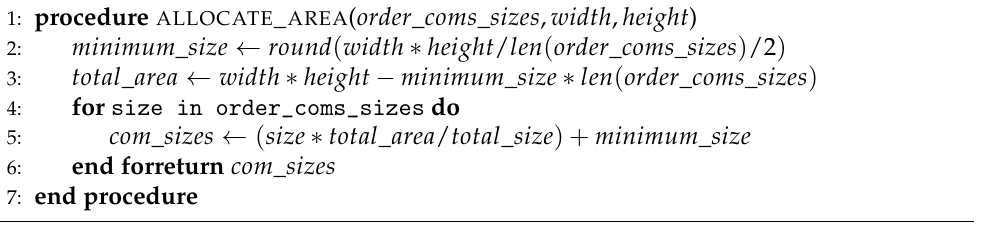
Algorithm 2 Allocation of areas to communities based on the communities’ sizes.